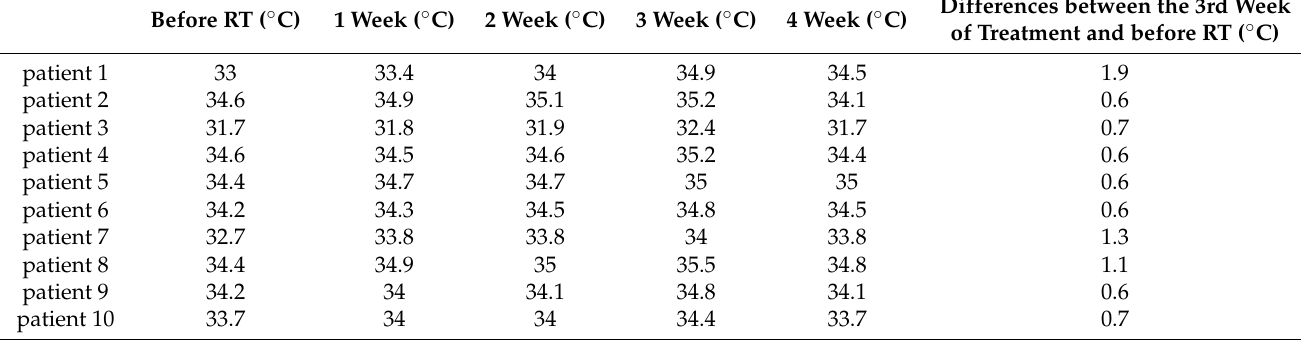
Table 1. Temperature change in PTV area for 10 exemplary patients, difference between the third week and mean temperature before radiotherapy.